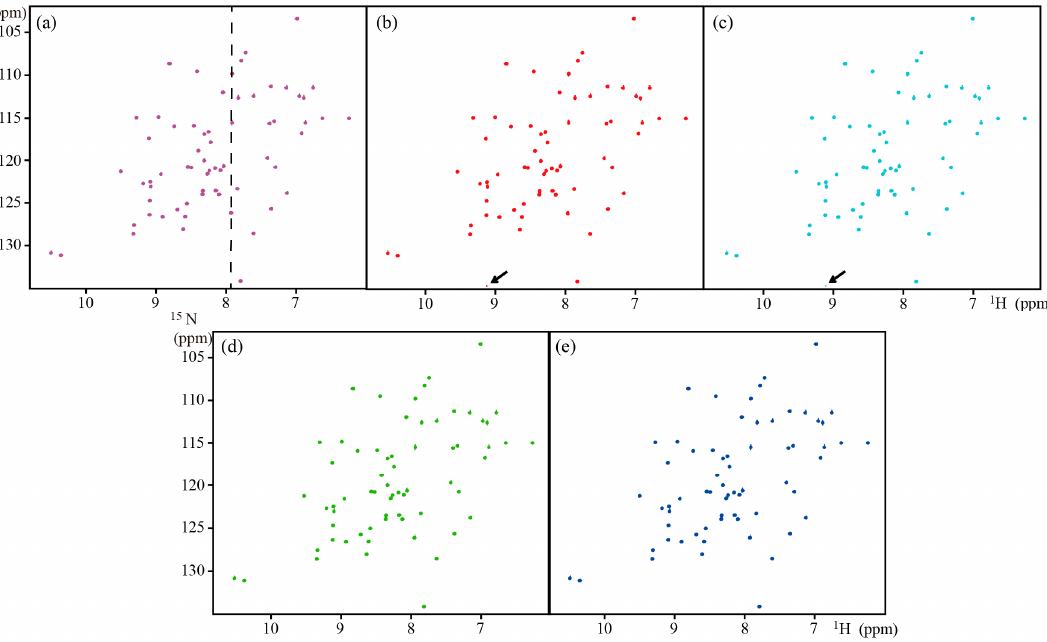
Note: Peak intensity correlations and error bars for the reconstructed spectra when 6% of data are acquired. The error bars are the standard deviations of correlations over 100 sampling trials. The numerical form of the table is C D ± , where C is the mean of correlation, and D is the standard deviation.